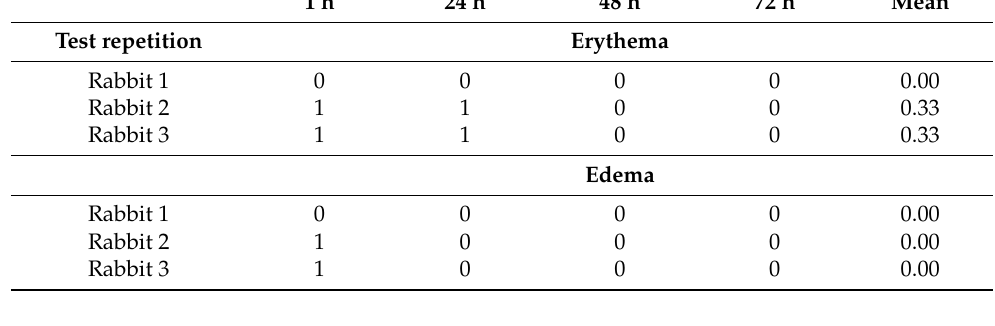
Table 7. Rabbit dermal response after AgNPs treatment.